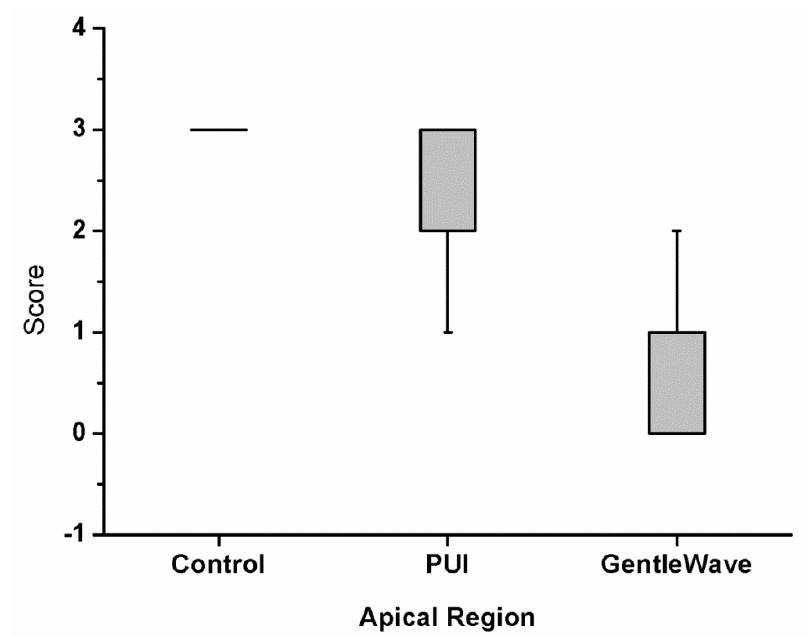
Figure 6. The level of biofilm attachment scores from all the apical sections and the two independent evaluators for the 39 molars left untreated (Group 1) or treated with passive ultrasonic activation (Group 2) or treated with the GentleWave System (Group 3). The modified scores utilized were—Score 0: no bacteria; Score 1: sparse and detached bacteria; Score 2: well defined biofilm (small colonies, < 50% of the canal wall covered); and Score 3: well defined biofilm (large colonies, > 50% of the canal wall covered). The average scores analyzed for the canals between Group 2 and Group 3 were statistically different ( p < 0.001).